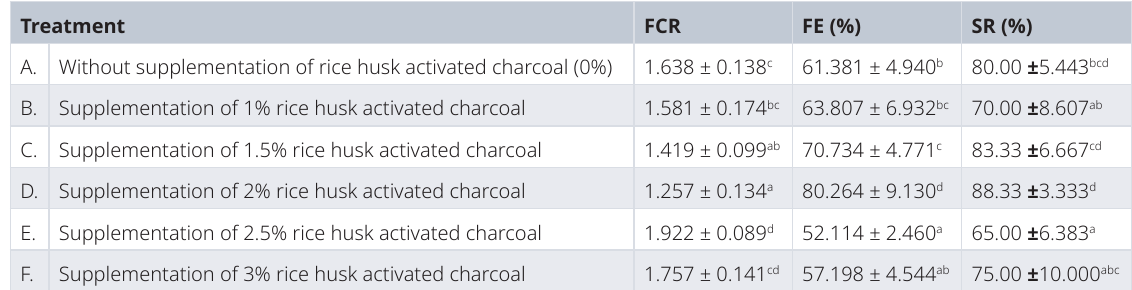
Table 3. Feed conversion ratio (FCR), feed efficiency (FE), and survival rate (SR) of giant trevally ( Caranx ignobilis ) juveniles.